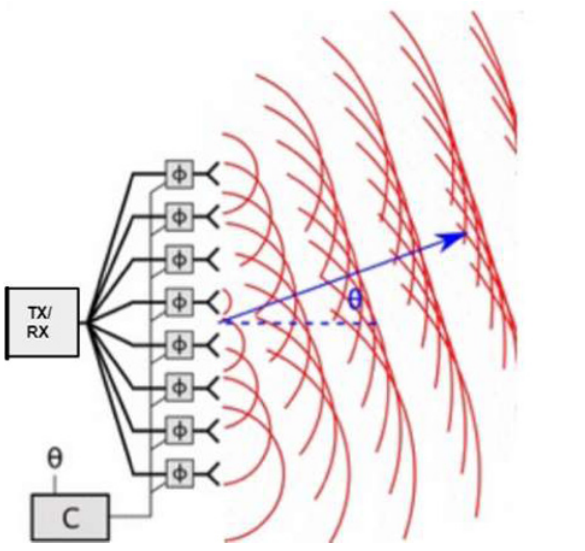
Figure 2. PESA radar architecture showing a single transmitter (TX), phase shifters ( ϕ ) being controlled by a computer system (C) with a desired transmit angle ( θ ). The red hemispherical lines show the direction of EM radiation [4]